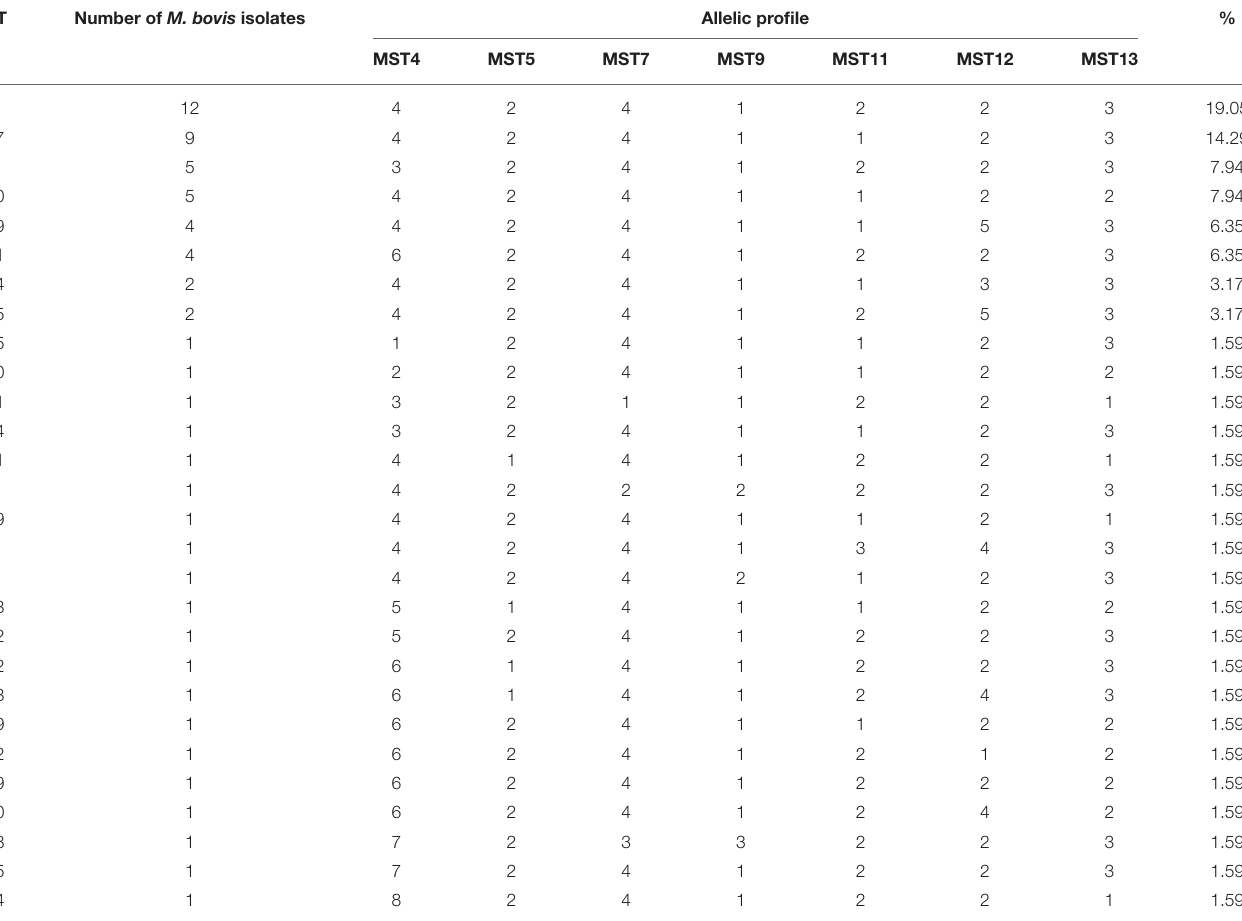
TABLE 1 | Twenty-eight (28) ST identified by the comparison of genotypic profiles of 63 isolates of M. bovis . ST Number of M. bovis